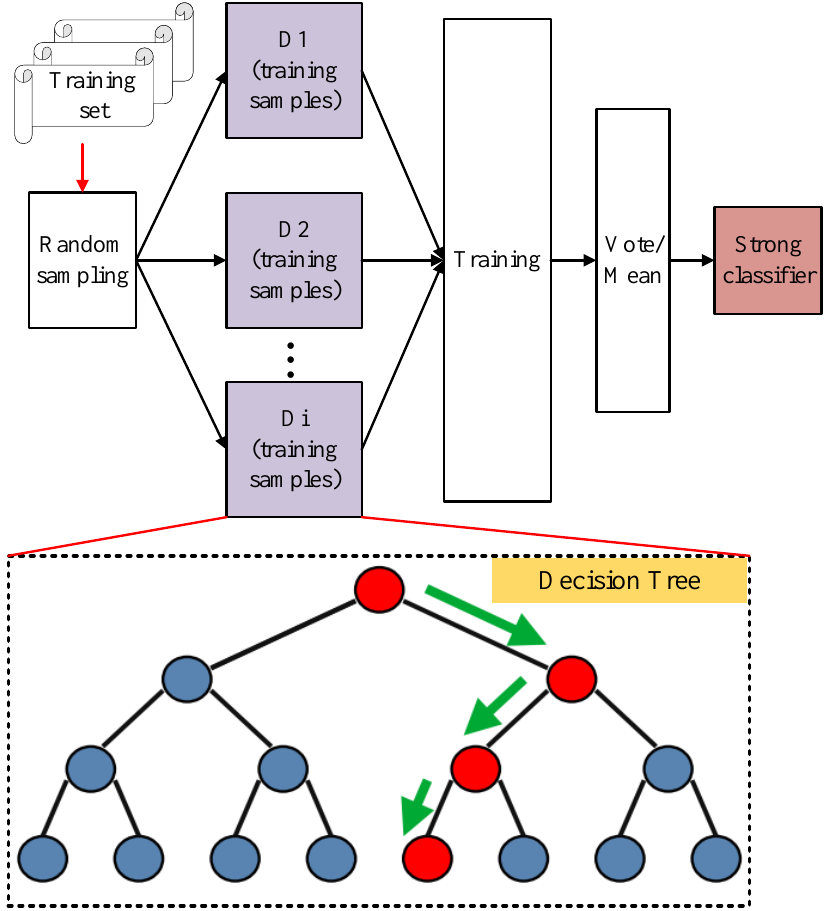
Figure 2. The training process of the random